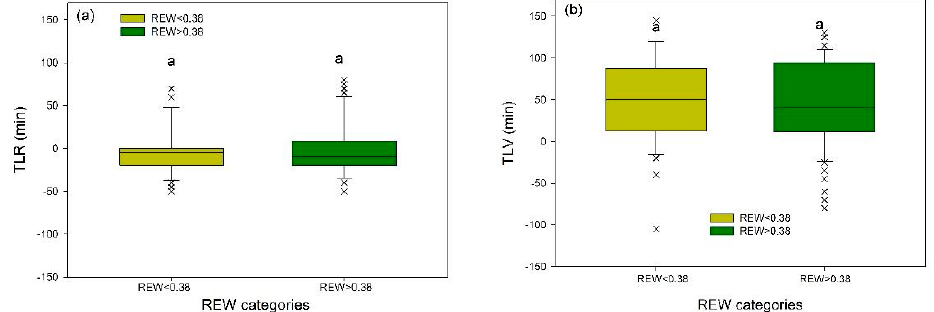
Figure 7. The distributions of time lag in di ff erent REW (relative extractable water) categories: REW < 0.38 and REW > 0.38. ( a ). The distributions of TLR (time lag between solar radiation and sap flux density) for di ff erent REW categories; ( b ). the distributions of TLV (time lag between sap flux density and vapor pressure deficit) for di ff erent REW categories. In the boxplots, the line drawn within the box represents the median; the box extends to the upper and lower quartiles. The di ff erent letter above the box indicate the significant di ff erence between the two boxes, and the same letter above the box indicate the insignificant di ff erence ( p < 0.05). Positive time lag values represent sap flux density (J s ) peaks preceding peaks in meteorological drivers, while negative time lag values represent J s lagging behind peaks in meteorological